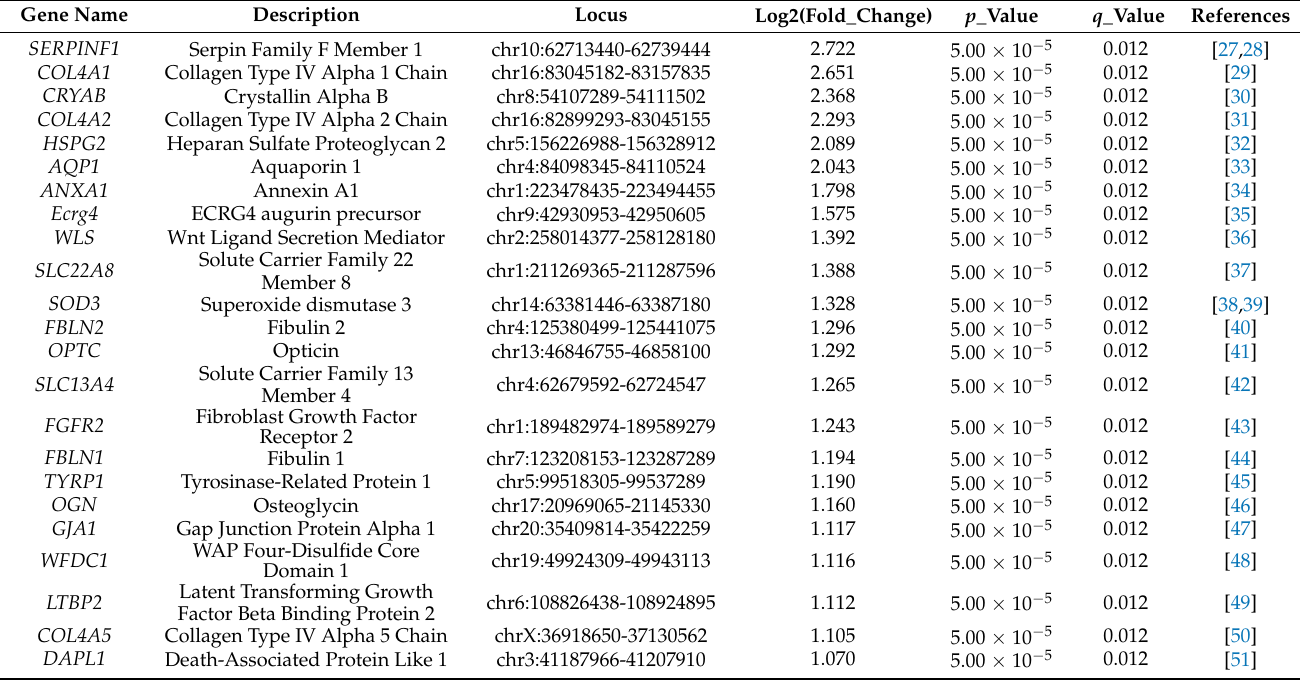
Figure 2. The volcano plot shows the distribution of the fold changes of each mRNA transcript in NK-5962-injected eyes versus vehicle-treated eyes. Genes that pass a threshold of log(FC) > 0.585, p value < 0.05 are highlighted by red (up-regulated) and blue (down-regulated), respectively. Only one gene ( LYVE1 ) was commonly down-regulated among samples treated with NK-5962. FC: fold change. Table 1. Up-regulated genes in NK-5962-treated